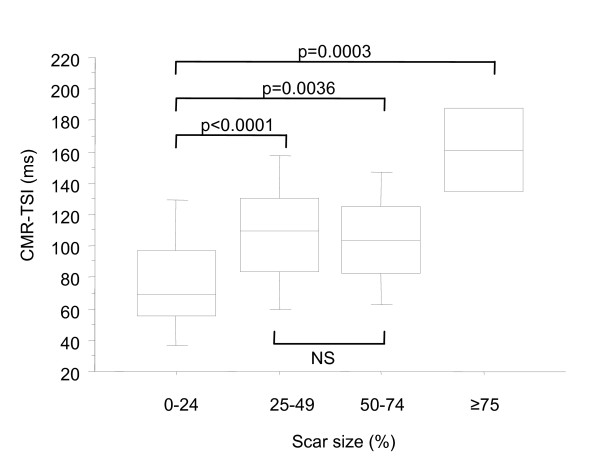
CMR-TSI in relation to scar size. Box-and whisker plots for C<R-TSI in relation to scar size. The five horizontal lines represent the 10th, 25th, 50th, 75th and 90th percentiles, from bottom to top.